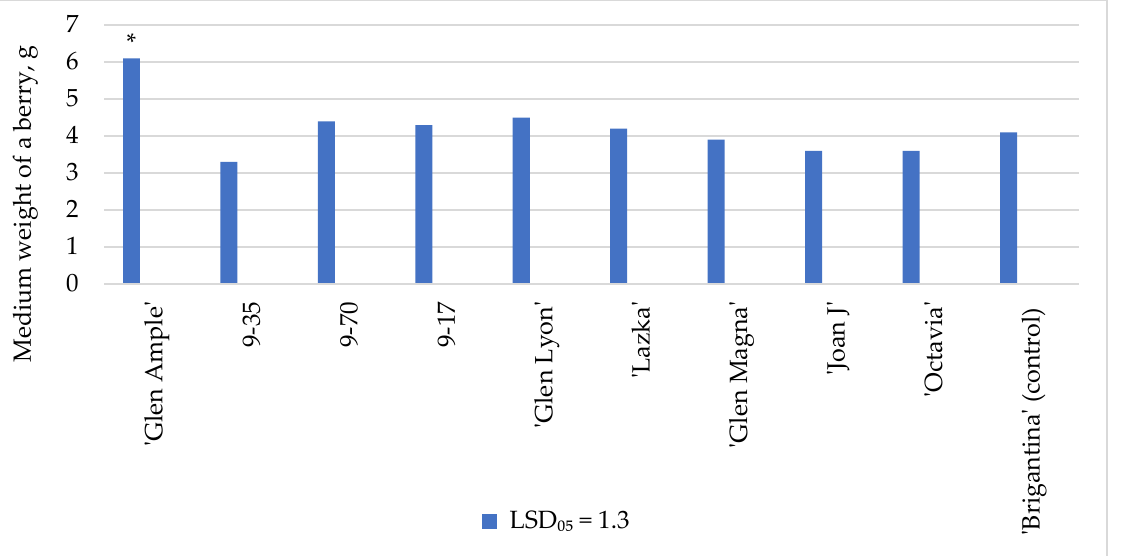
Figure 6. Average berry weight, g (2019–2021). *—significant differences at the 5% significance level.